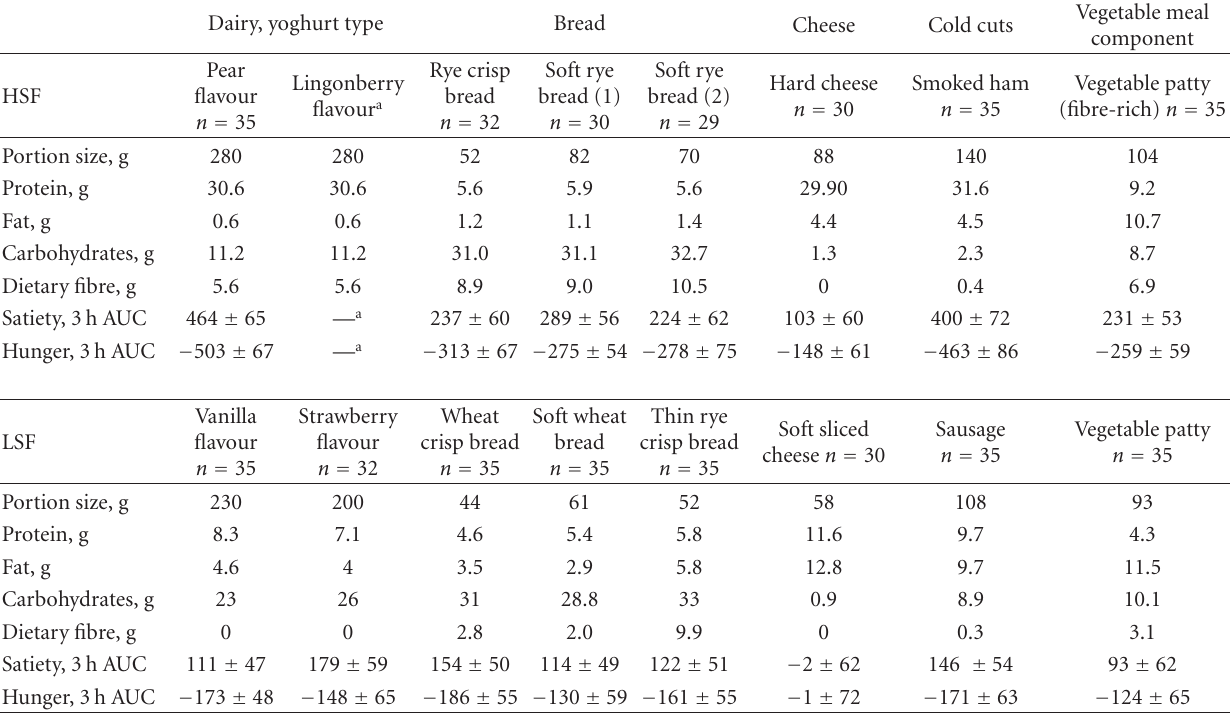
Table 2: Foods selected to the intervention and their tested portion sizes, macronutrient and dietary fibre contents and 3h satiety/hunger